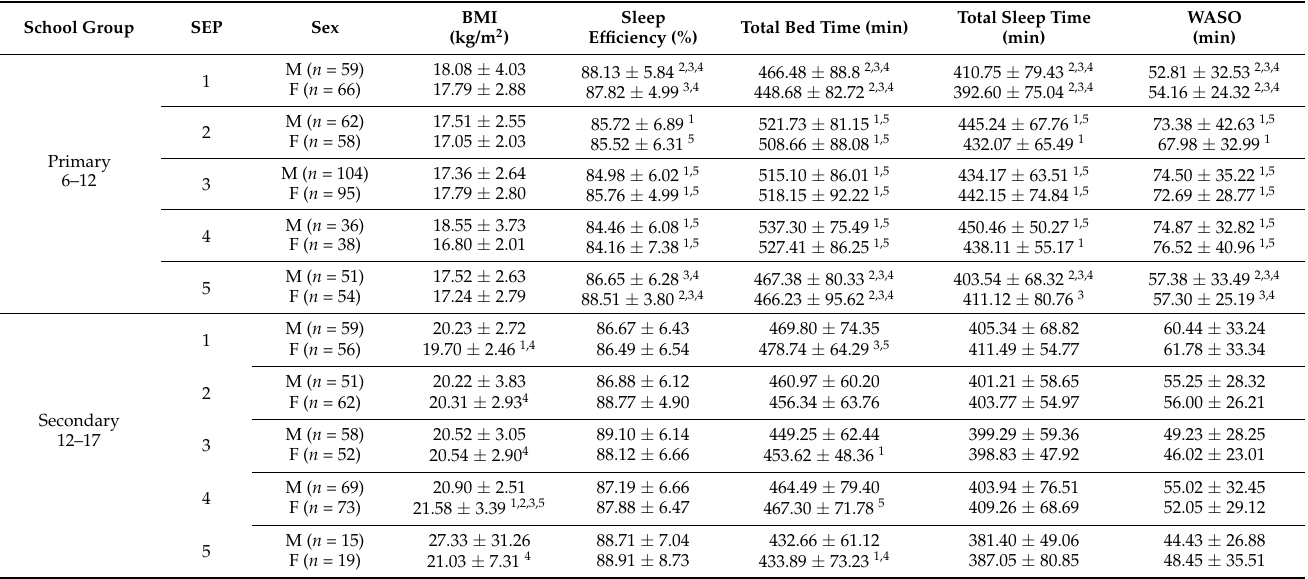
Table 5. Results of the daily sleep quality analysis in each SEP level divided by sex and school level